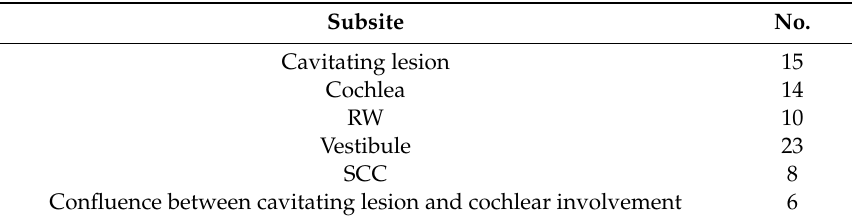
Table 1. Numbers of the ears with otosclerotic foci at each anatomical subsite. Subsite